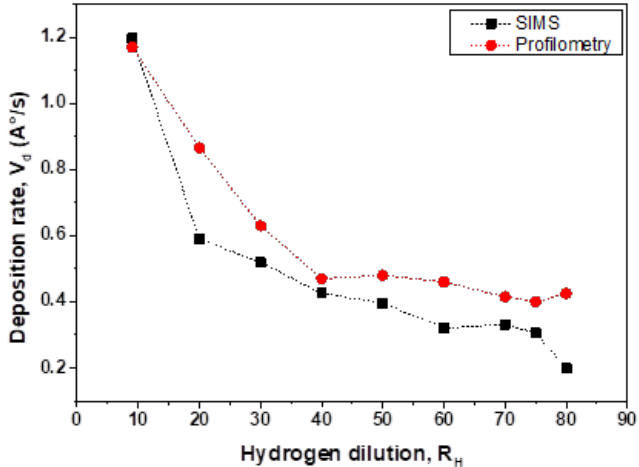
Figure 1. Deposition rate as a function of hydrogen dilution ratio V d (R H ) calculated from step measurements and estimation of depth from measurements of the crater created by SIMS.